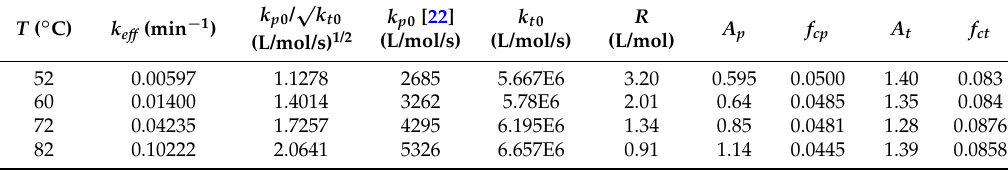
Table 1. Values of kinetic and diffusion-controlled parameters obtained in this study during bulk polymerization of HEMA with the benzoyl peroxide (BPO) initiator.